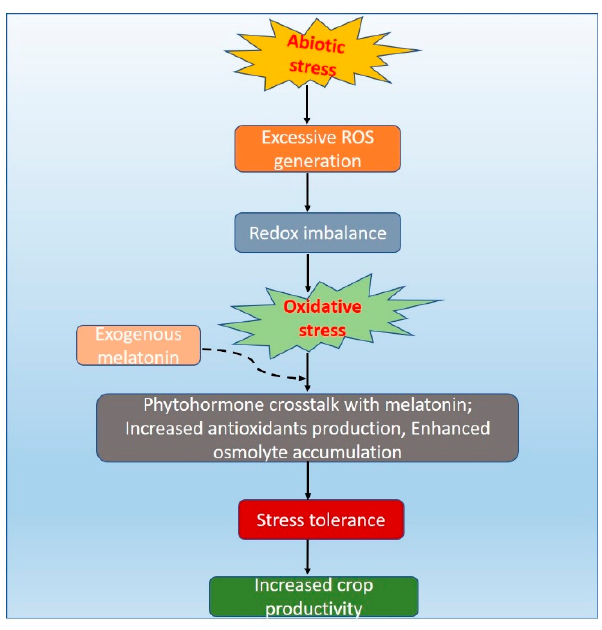
Figure 2. Role of melatonin in overcoming abiotic